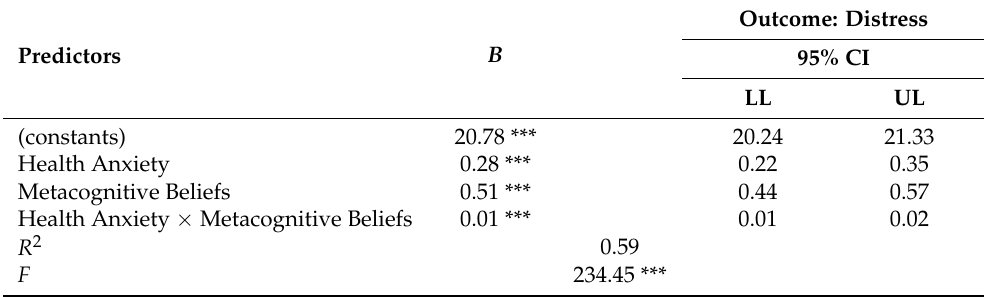
Table 6. Moderation of metacognitive beliefs between health anxiety and distress (cyberchondria construct) ( N = 500).